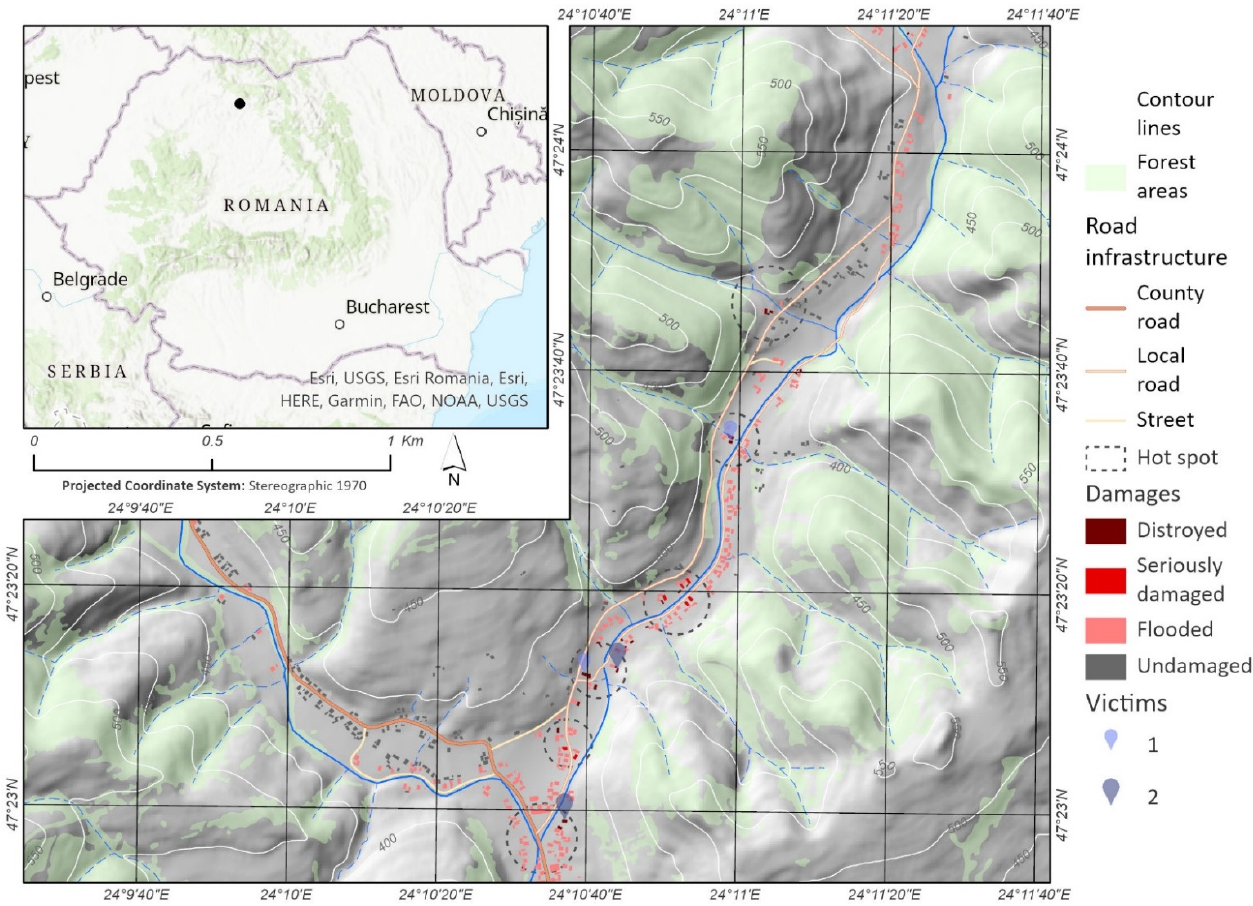
Figure 1. The geographic location of the study area.